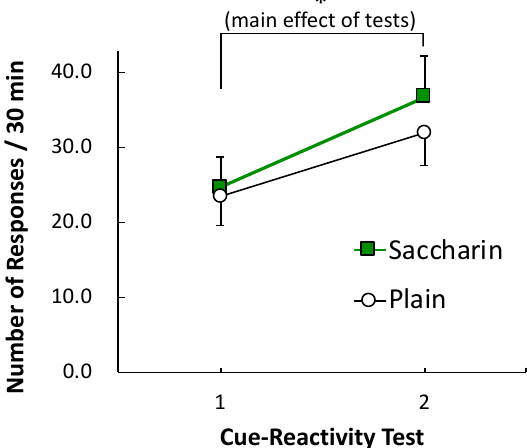
Figure 3. Mean number of lever-press responses in cue-reactivity tests 1 and 2. Data points indicate means ± SEMs ( n = 7 for each group). Asterisk indicates a significant difference between the tests.